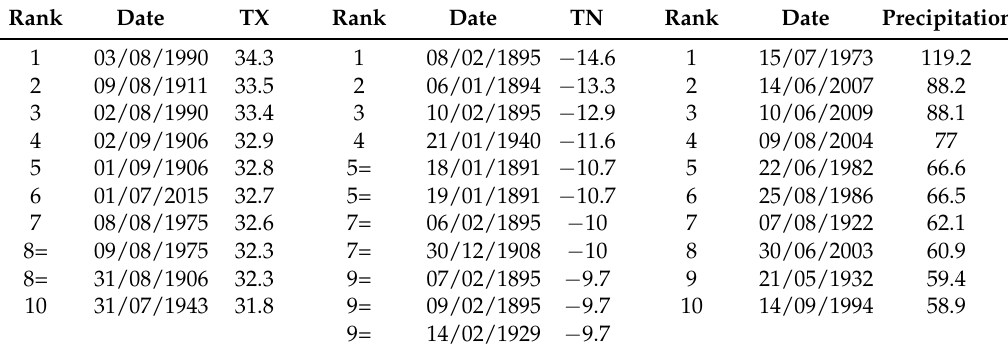
Table 2. The top ten record days for precipitation, TX and TN. Units in ◦ C and